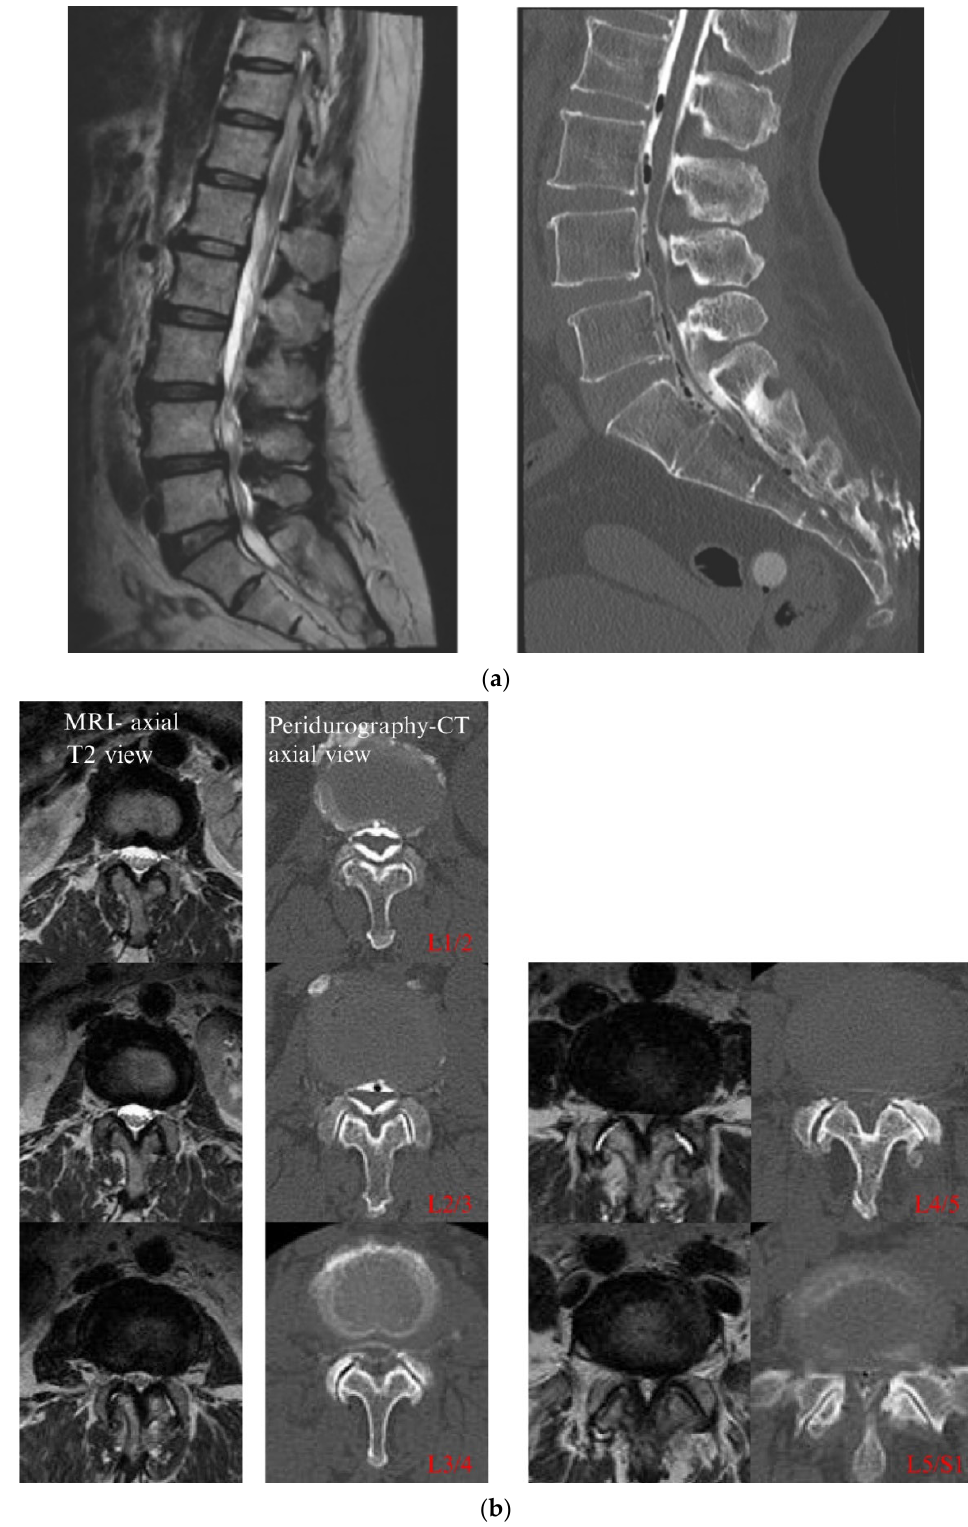
Figure 3 . ( a ) Lumbar spinal canal stenosis. MRI sagittal T2 view and CT epidurography sagittal view. CT, computed tomography; MRI, magnetic resonance imaging. ( b ) Lumbar spinal canal stenosis. MRI axial T2 view and CT epidurography axial view. CT, computed tomography; MRI, magnetic resonance imaging.